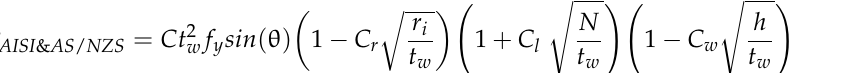
Figure 2. Four loading cases for web crippling tests